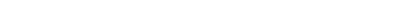
over the course of the black hole evaporation. For C R A hor (cid:0)